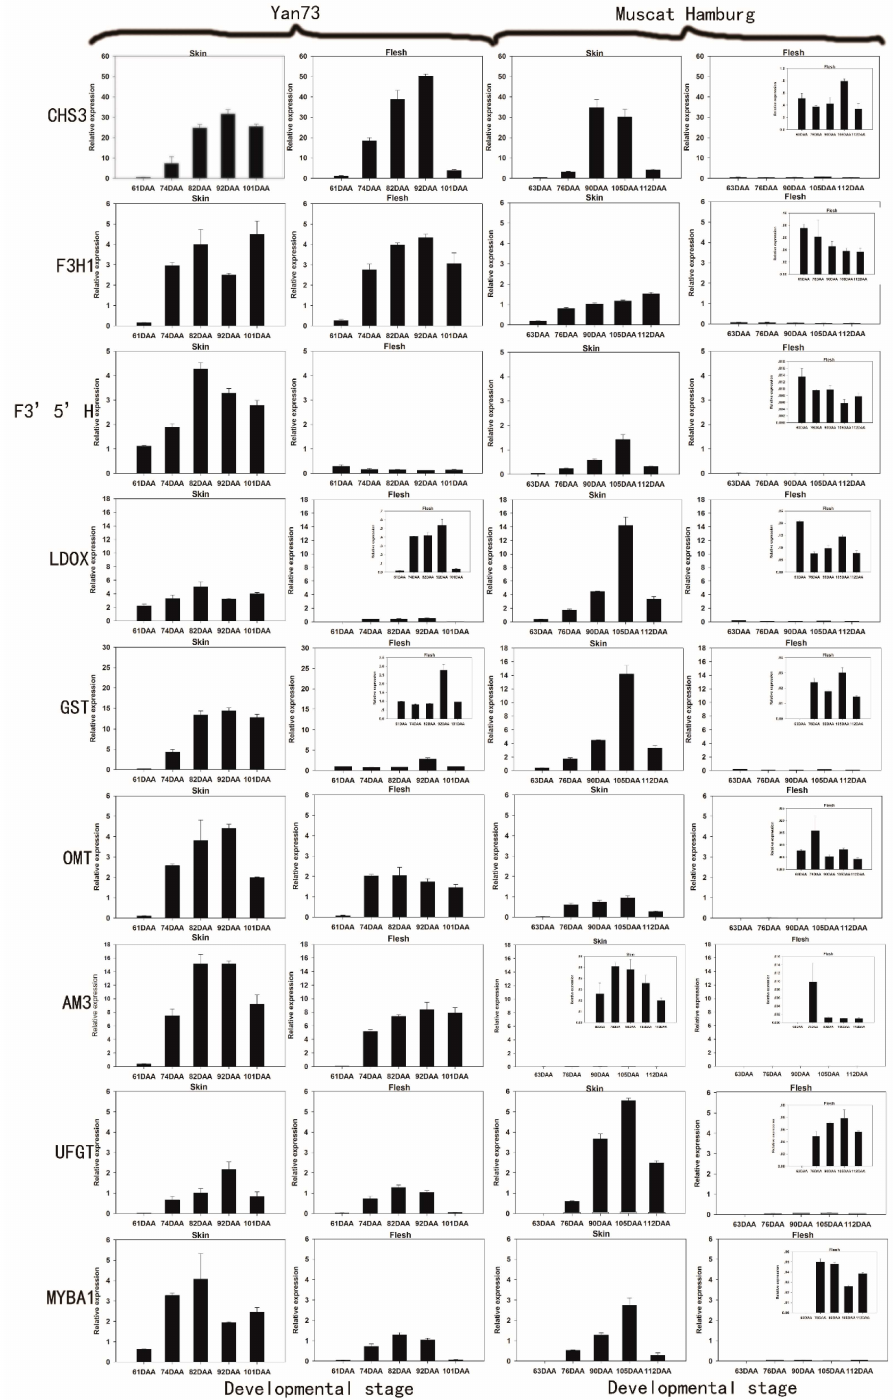
Figure 1. Expression patterns of anthocyanin biosynthetic genes in the skin and flesh of Yan 73 and Muscat Hamburg cultivars across five developmental stages. The data are derived from qPCR analysis and are normalized to VvUbiquitin . The transcriptional levels of the same gene in the skin and flesh tissues of Yan 73 and Muscat Hamburg are expressed on the y axes with the same scale, and relatively lower values are magnified in inset graphs with y axes with narrower scales. Berry developmental stage is referred to on the x axis. DAA, days after anthesis; 61 DAA (63 DAA) pre-véraison; 74 DAA (76 DAA), 50% véraison green; 82 DAA (90 DAA), 50% véraison red; 92 DAA (105 DAA), 100% véraison; 101 DAA (112 DAA) , harvest. Error bars illustrate the standard errors for three replicates.